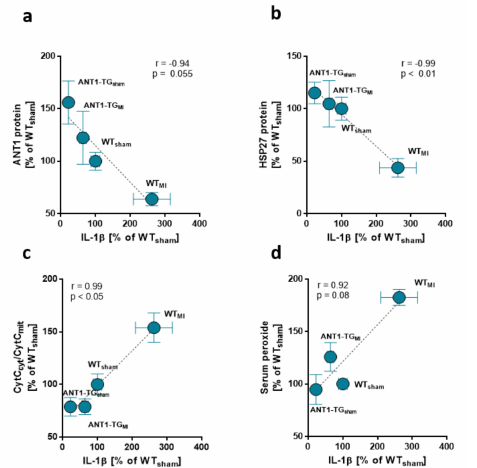
Figure 2. Low IL-1 β expression correlates with mitochondrial integrity and low oxidative stress in ANT1-TG hearts. Mean IL-1 β levels found in the sham and infarcted hearts of WT and ANT1-TG rats negatively correlated with the mean expression of ( a ) HSP27 and ( b ) ANT1 and were associated with ( c ) an increase in the ratio of cytosolic to mitochondrial cytochrome C (CytCcyt/CytCmit), a marker for mitochondrial function, and ( d ) serum peroxide levels [15]. Correlation coefficients and p -values determined by the Pearson’s correlation test are shown in the graphs, n = 5–6 for each group. IL: interleukin; WT: wild-type; ANT1-TG: adenosine nucleotide translocase 1 transgenic rat; HSP: heat shock